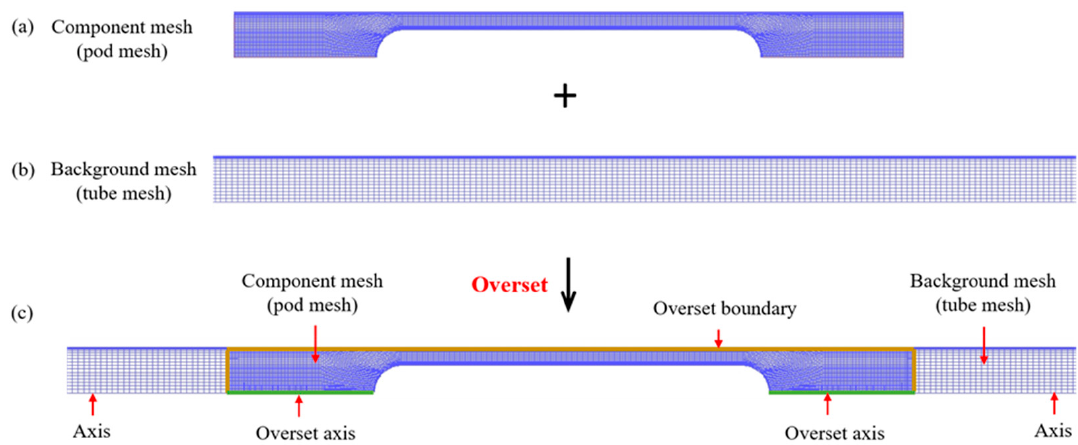
Figure 2. Schematic of the overset mesh generation. The number of meshes in this figure is only 1 / 10 of the number of final meshes. Yellow lines represent the overset boundaries where the pod mesh ( a ) and tube mesh connect ( b ). When two meshes overlap, the redundant mesh of the tube mesh vanishes as shown in ( c ).